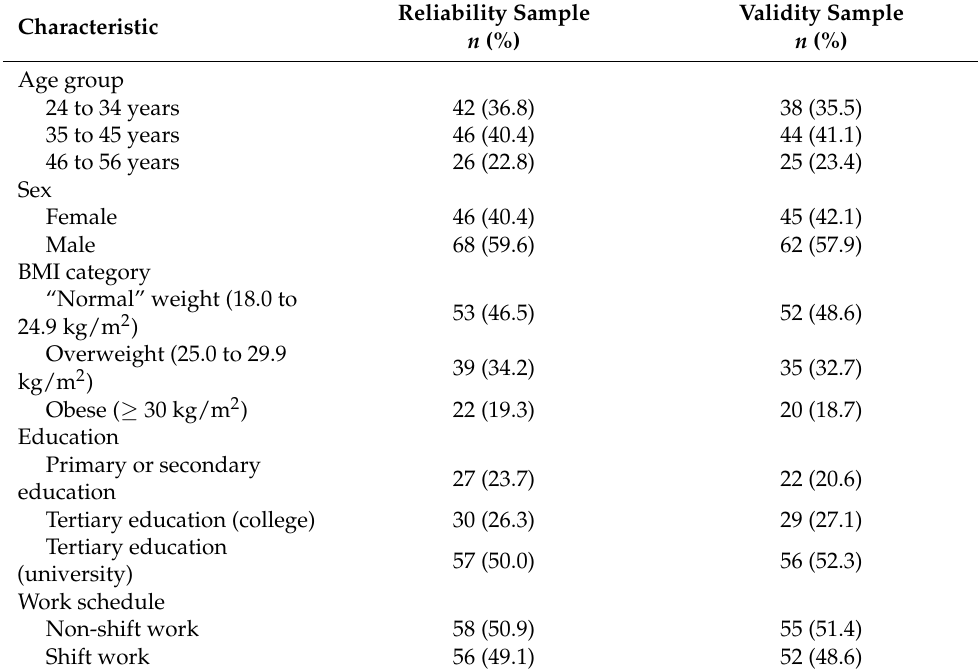
Table 1. Participant characteristics (reliability sample, n = 114; validity sample, n = 107).